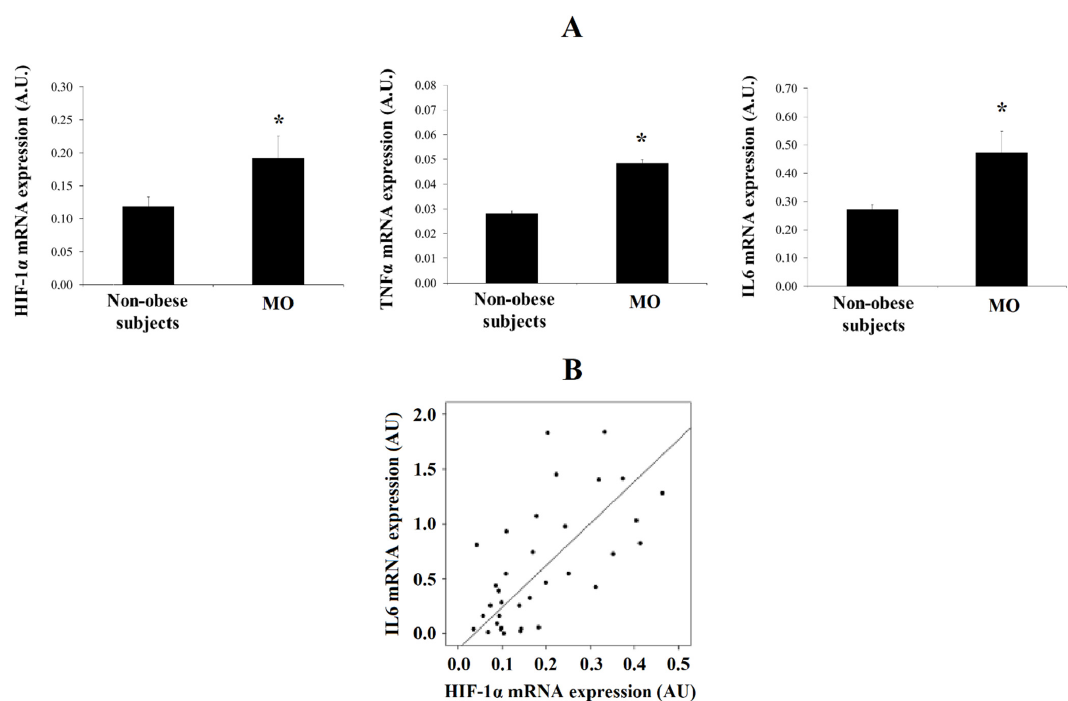
Figure 1. ( A ) Levels of mRNA expression of HIF-1 α , TNF α and IL6 in human visceral adipocytes from non-obese subjects and patients with morbid obesity (MO). Data are the mean ± SEM. * p < 0.05: significant differences between non-obese subjects and MO. ( B ) Significant correlation found in visceral mature adipocytes between the mRNA expression of HIF-1 α and IL6.